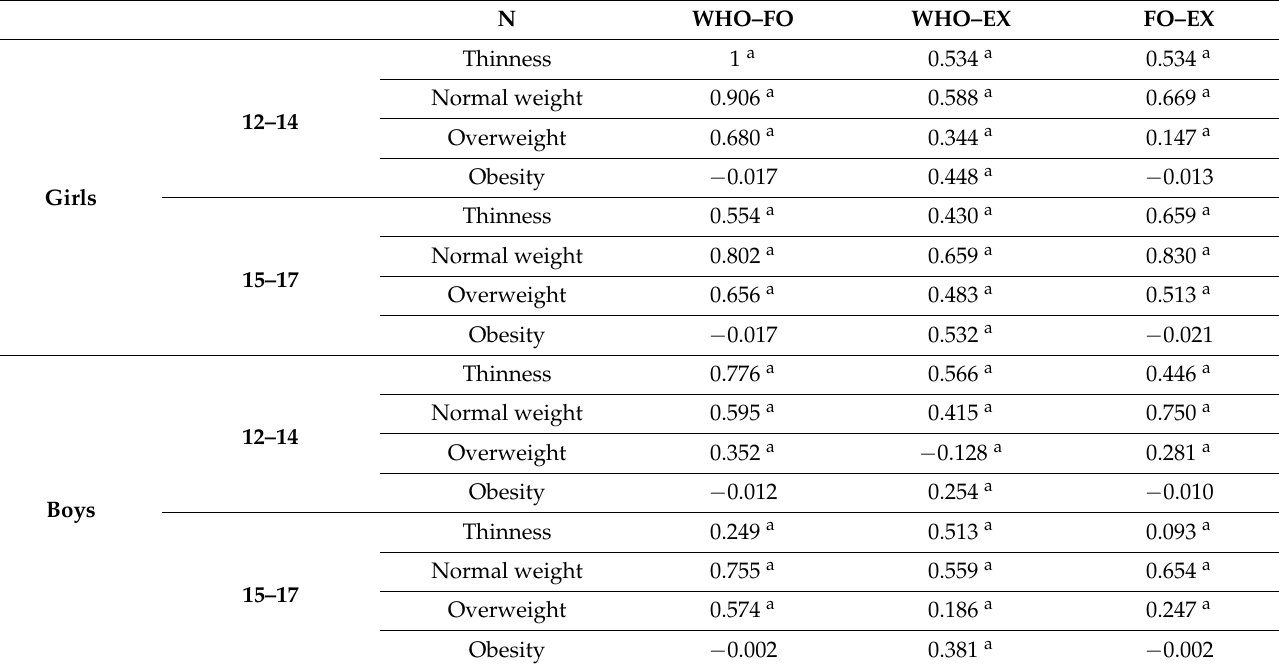
Table 4. Concordance in diagnostic criteria by the WHO, FO, and EX references according to bodyweight category, age, and sex